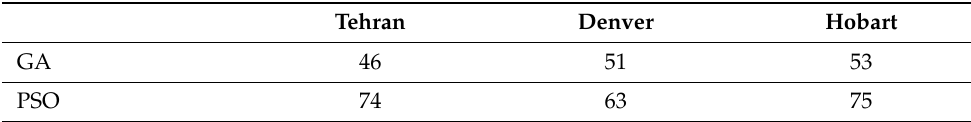
Table 1. The number of features selected with PSO and GA.